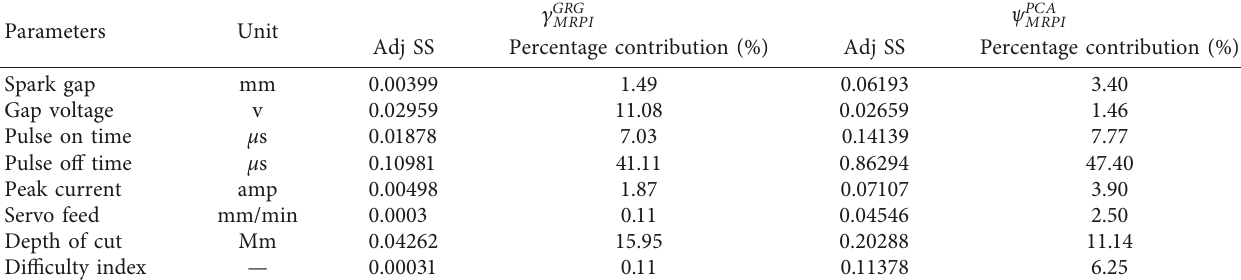
Table 19: Proportion of contribution encountered by the process parameters.